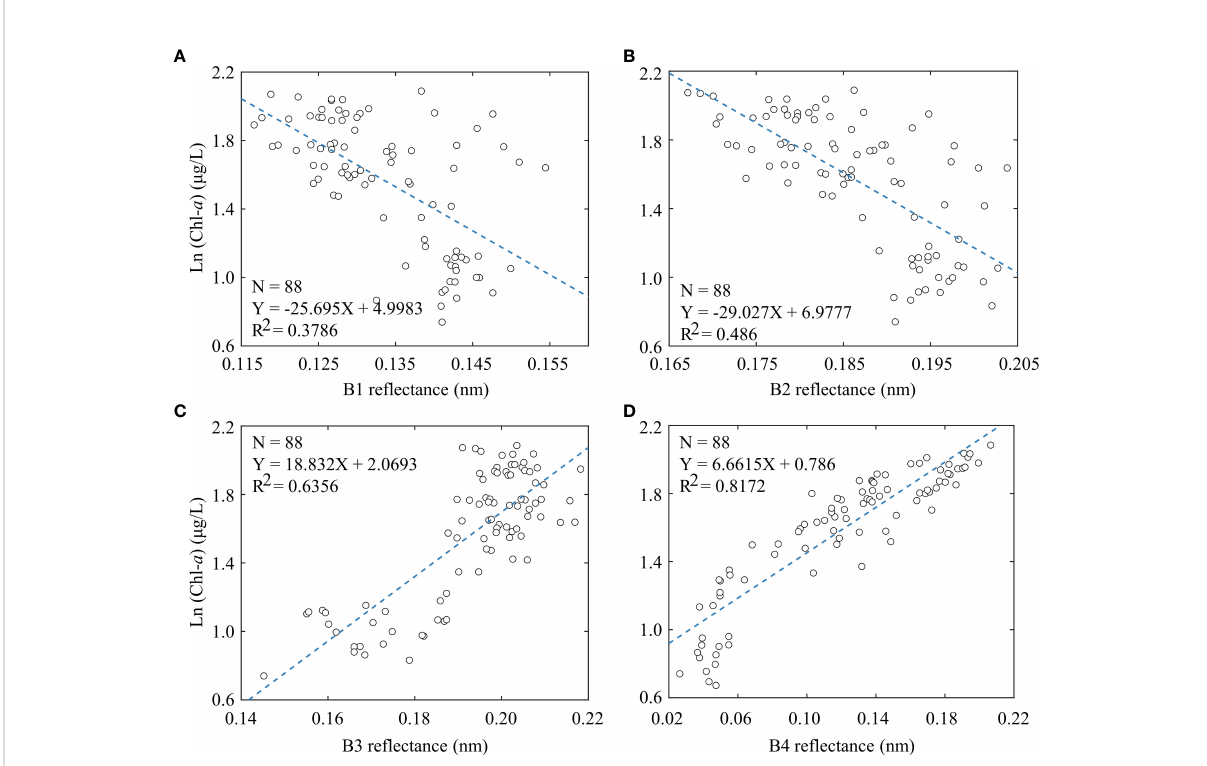
FIGURE 2 Correlation between the band value retrieved from PMS image after atmosphere correction and sampled Chl- a . (A – D) : The linear relationship between the re fl ectance of band 1, 2, 3, 4 and Chl- a concentration. The abscissa is the re fl ectance of a single band, and the ordinate is the natural logarithm of Chl- a [Ln (Chl- a